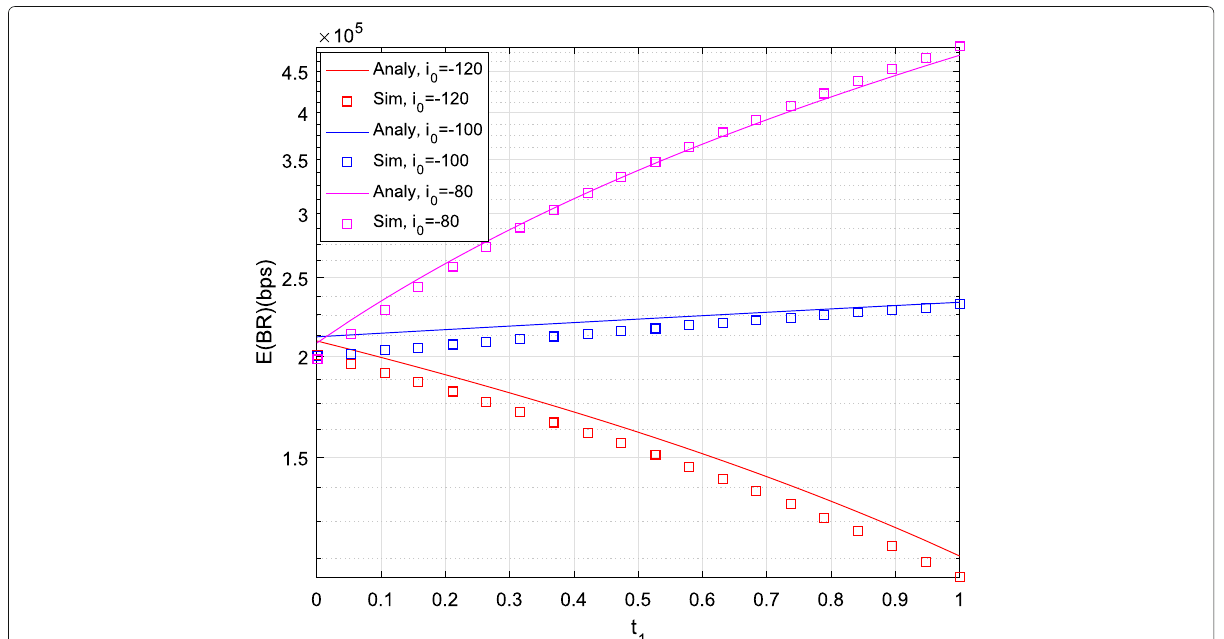
Fig. 17 Average BR as a function of the transmitting time in time slot 1 for the hybrid system (AMC) with (cid:5) = 1, t ( 1 ) / t ( 2 ) = 9 dB and p max → ∞